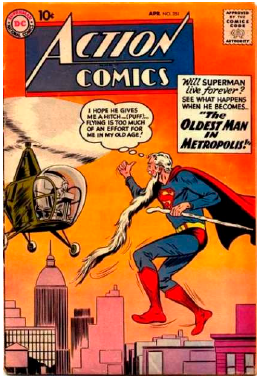
Figure 3. Action Comics #251, “The Oldest Man in Metropolis” (April 1959) [10]